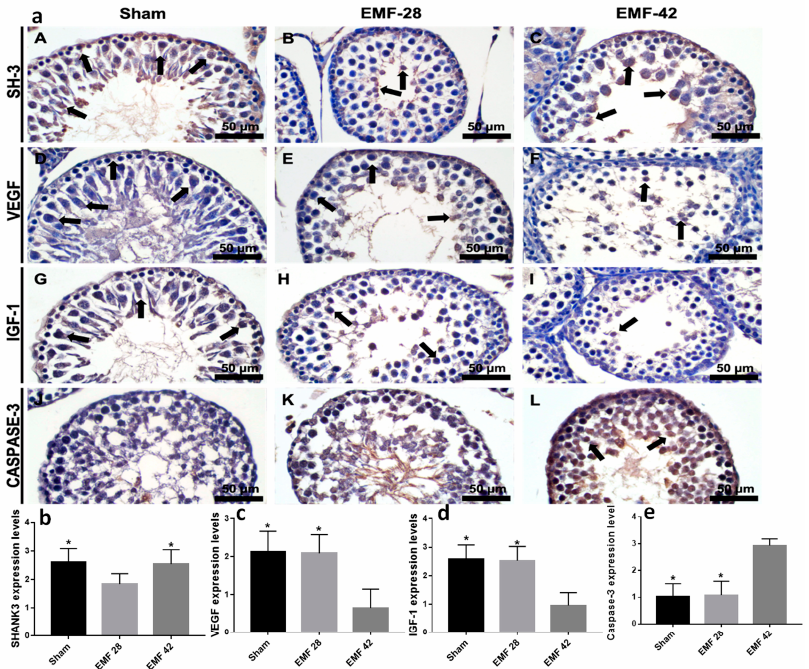
Figure 4. ( a ) ; Immunostaining of rat testes with SHANK3, VEGF, IGF1, and caspase-3 antibodies. (A, D, G, J - Sham group; B, E, H, K - EMF-28 group; C, F, I, L - EMF-42 group). Black arrows, immunopositive cells. EMF, 50 Hz electromagnetic field exposure (4 h/day, 5 days/week for 7 (EMF- 28) and 9 (EMF-42) weeks); Sham group was exposed to the same conditions as the EMF group, except for the EMF exposure. Scale bar, 50 µm. SHANK3, VEGF, IGF1, and caspase-3 immunohisto- chemistry scores of Sham ( n = 7), EMF-28 ( n = 7), and EMF-42 ( n = 7) group rat pups’ testes (one-way ANOVA with subsequent LSD multiple comparisons test). * p < 0.0001, significantly different from EMF-28 group ( b ), * p < 0.0001, significantly different from EMF-42 group ( c – e ). There was a difference in VEGF and IGF1 immunoreactivities between groups (F (2, 20) = 1905.0, p < 0.0001, and F (2, 20) = 2598.0, p < 0.0001, respectively). The VEGF and IGF1 immunoreactivities were significantly decreased in EMF-42 group testis tissues compared to Sham and EMF-28 groups ( p < 0.0001, Figure 4a,c–d). No significant difference was